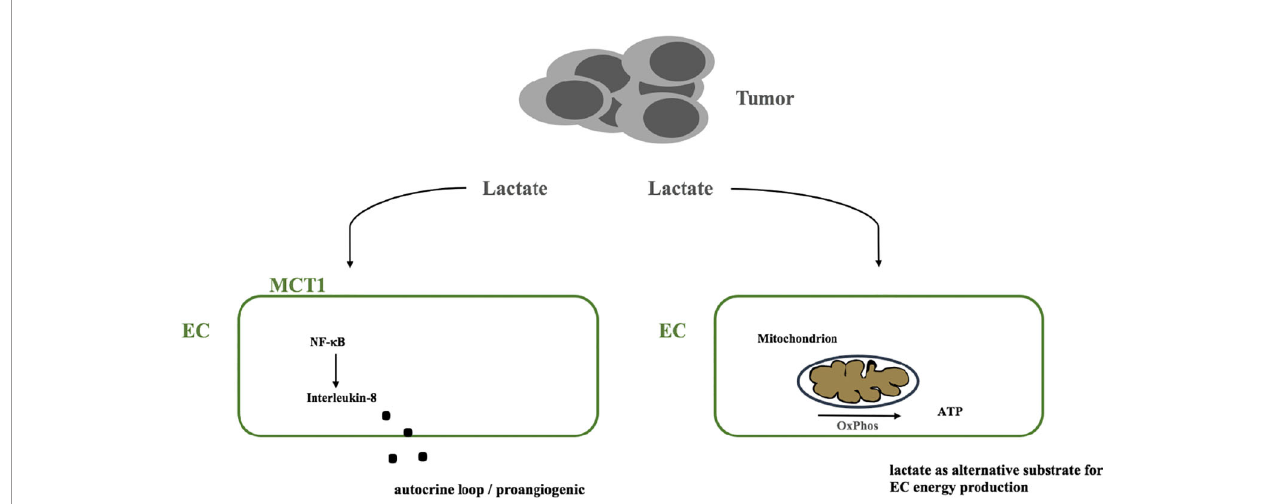
FIGURE 2 | Model of the potential dual role of tumor-derived lactate. (i) as a signaling molecule that triggers a NF- k B dependent autocrine proangiogenic program via IL-8 and (ii) as an alternative substrate that ECs metabolize via the respiratory chain to produce ATP. MCT1, monocarboxylate transporter 1; EC, endothelial cell; OxPhos, oxidative phosphorylation; ATP, adenosintriphosphate; NF- k B, nuclear factor kappa